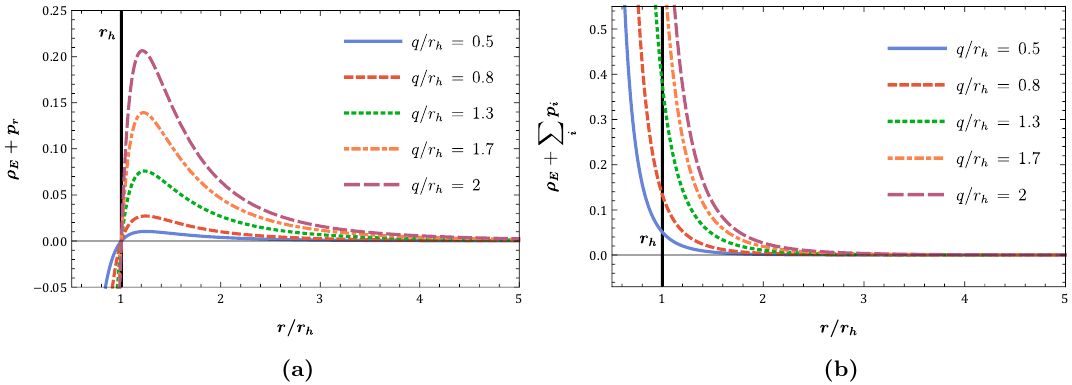
Figure 4. (a) The quantity ρ E + p r and (b) the quantity ρ E + P r for r h = 1 and different values of the dimensionless parameter q/r h